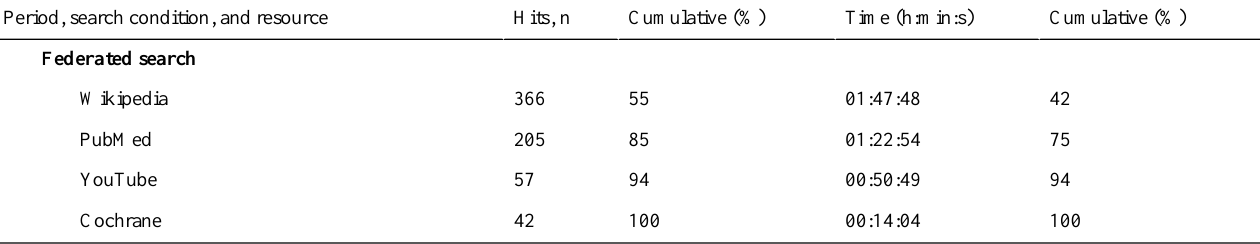
Table 5. Median and mean values of time spent per resource for the web and federated condition stratified by search period. Federated